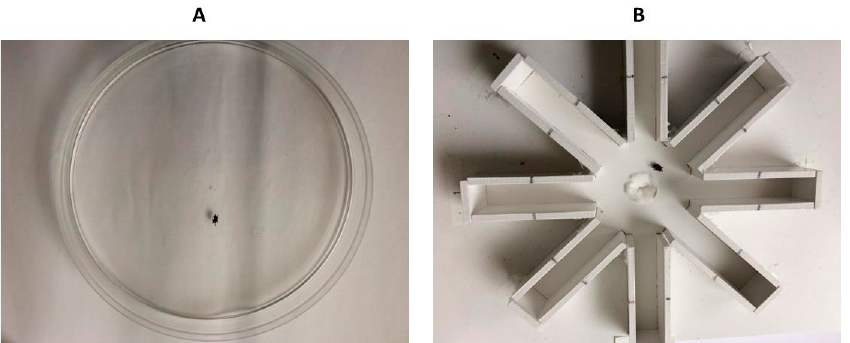
Figure 2. The open-field glass arena ( A ) and the eight radial-arm maze ( B ) used successively during behavioural tests for wild caught spiders immediately after capture (NE) or after 15 days in captivity (NE-15) and for laboratory reared spiders (L, LM, S and SM